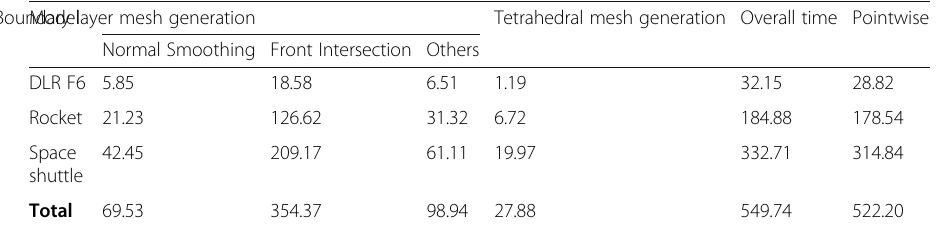
Table 1 Timing statistics (unit: seconds) ModelBoundary layer mesh